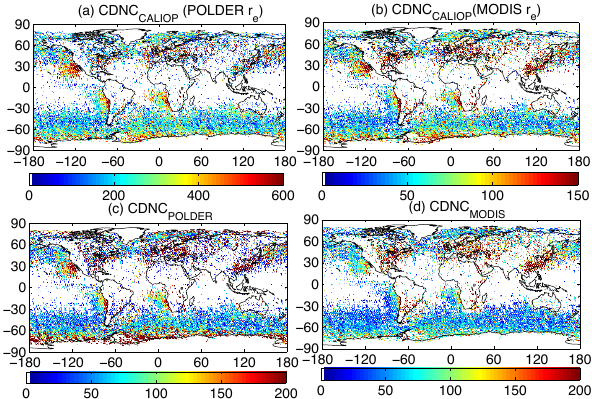
Figure 7. Geographical distributions of CALIOP CDNC (cm − 3 ) derived by using the POLDER r e (a) , MODIS r e , 3 . 7 (b) , POLDER CDNC (c) and MODIS CDNC (d)